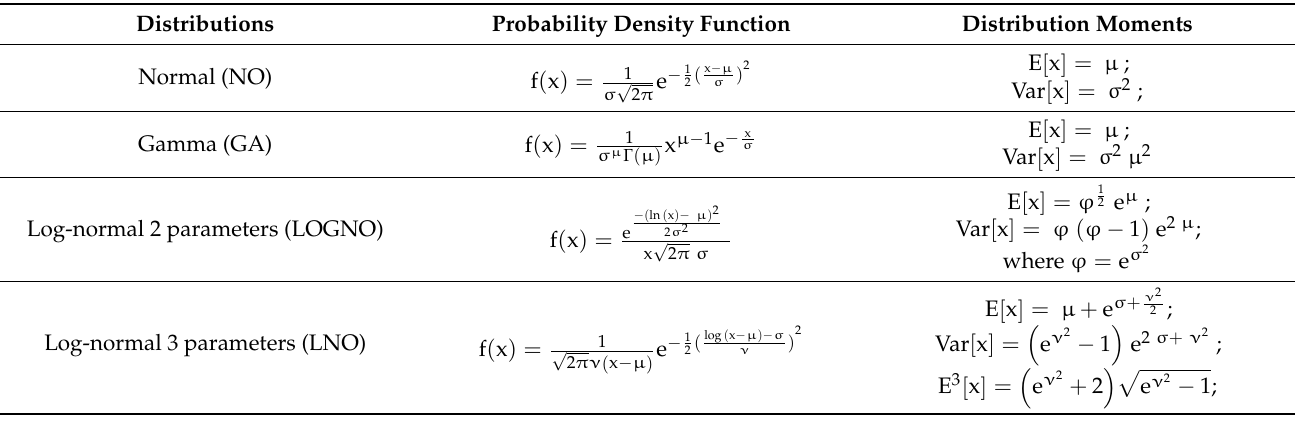
Table 1. Probability density functions with related distribution